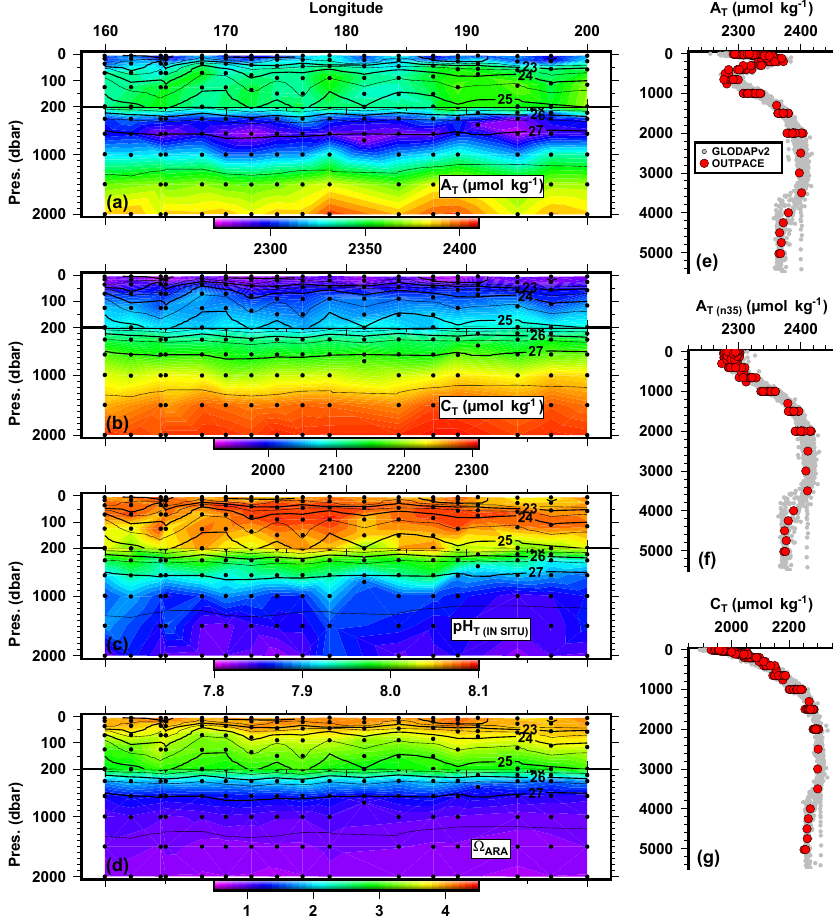
Figure 3. Longitudinal variations in (a) A T , (b) C T , (c) pH T and (d) (cid:127) ara along the OUTPACE transect between the surface and 2000dbar depth. Black contour lines represent the isopycnal horizons based on potential density referenced to a pressure of 0dbar. Vertical profiles of (e) A T , (f) A T n 35 and (g) C T of the entire OUTPACE dataset (red dots) superimposed on the GLODAPv2 data corresponding to the OUTPACE area (gray